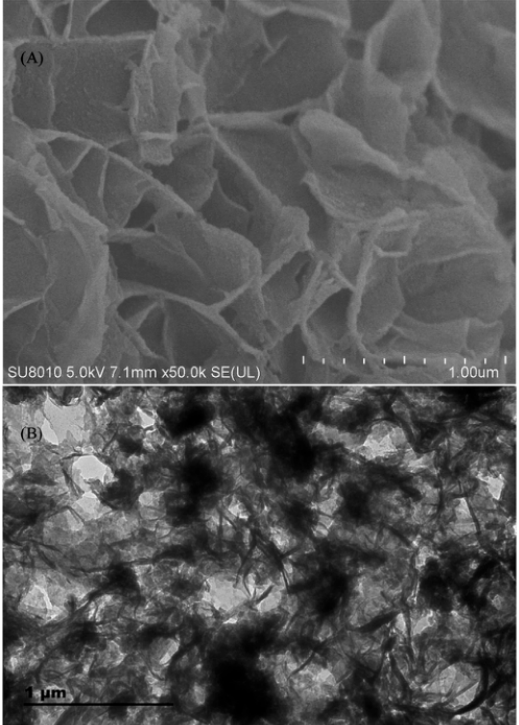
Figure 17. SEM ( A ) and TEM ( B ) images of EH-Mag-GO. Reprinted with permission from Ref. [9]. Copyright (2018) Elsevier. GO-Fe 3 O 4 magnetic nanocomposites, using a simple chemical coprecipitation method, was successfully synthesized by Lu and co-workers [114]. In this method, Fe 3 O 4 formed by the co-precipitation of Fe 2+ and Fe 3+ was successfully bonded to the GO with the aid of the -COOH under ultrasound. The preparation process of GO-Fe 3 O 4 was shown in Figure 18. GO-Fe 3 O 4 was applied to SPME as an adsorbent to extract eight psychoactive drugs from urine prior to LC-MS/MS analysis. The limit of detection of the analytical method was 0.02–0.2 μ g/L, and the intra-day and inter-day RSD were in the range of 2.7– 13.1% and 3.9–13.7%, respectively.